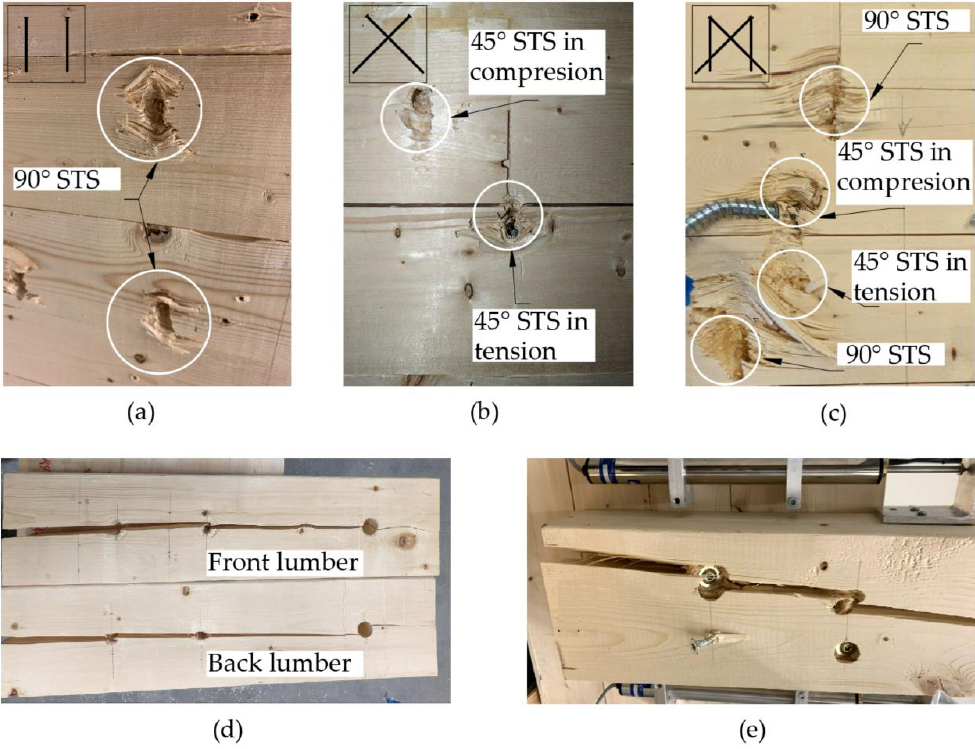
Figure 5. Failure on wood: ( a ) wood crush in 90° STSs; ( b ) wood crush in 45° STSs; ( c ) wood crush in mixed angle connection (90° and 45°); ( d ) wood splitting in 10 mm connection with STSs installed at 90°; and ( e ) wood splitting in 8 mm connection with STSs installed at mixed angles (90° and 45°). Table 3. Mechanical properties of STS connections under monotonic